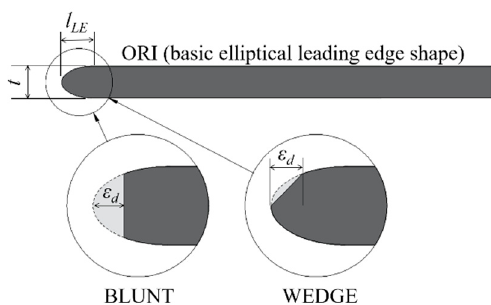
Figure 3. The BLUNT and WEDGE deformations of the leading edge.